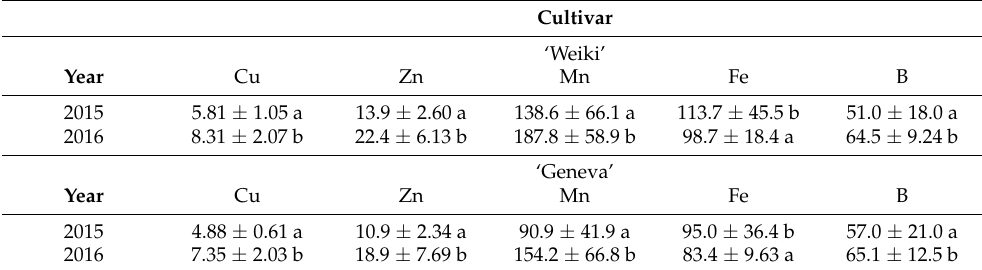
Table 4. Leaf micronutrient concentration (mg kg − 1 DW): cultivar and year